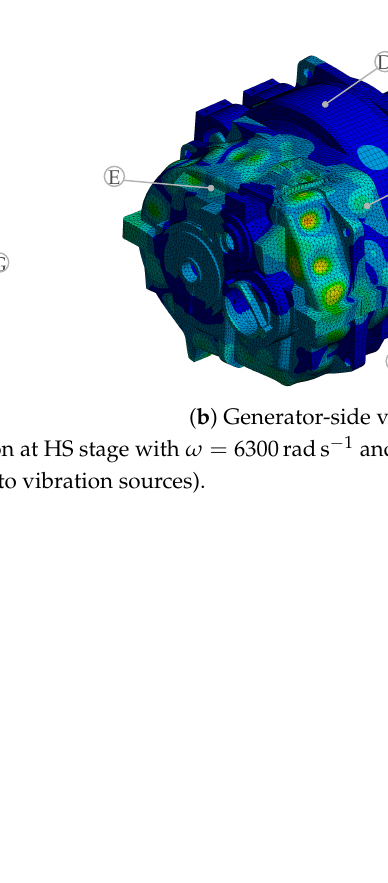
Figure 19. Operating speed of the HS shaft during measurement runs with different operating condi-